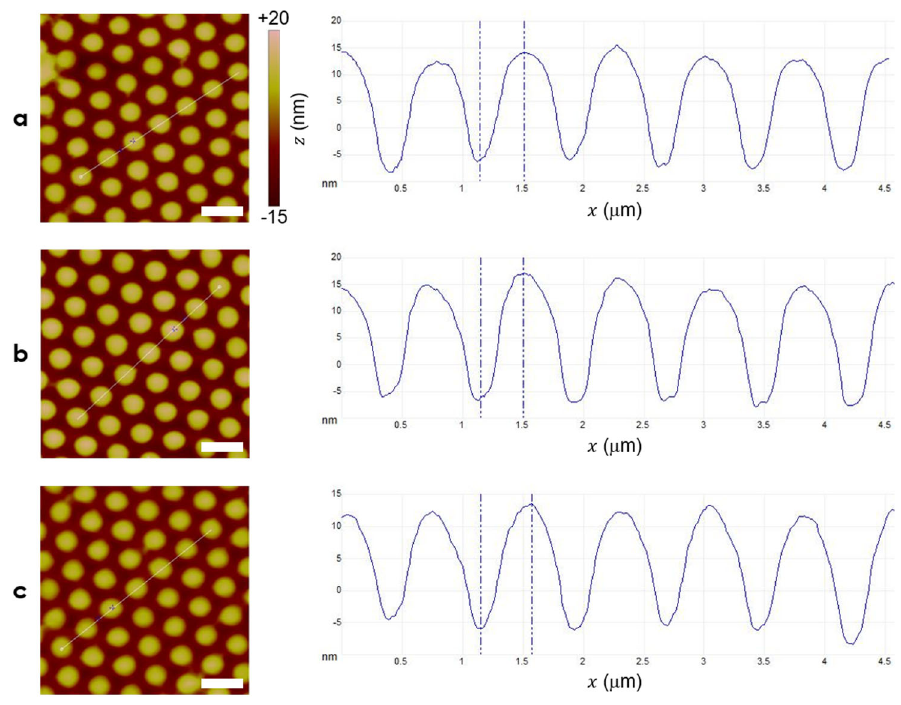
Figure A3. AFM scans of the nanolenses fabricated with different contact times: ( a ) 1.0, ( b ) 5.0, and ( c ) 40 min. The insets on the right show the profiles along the white scan lines.